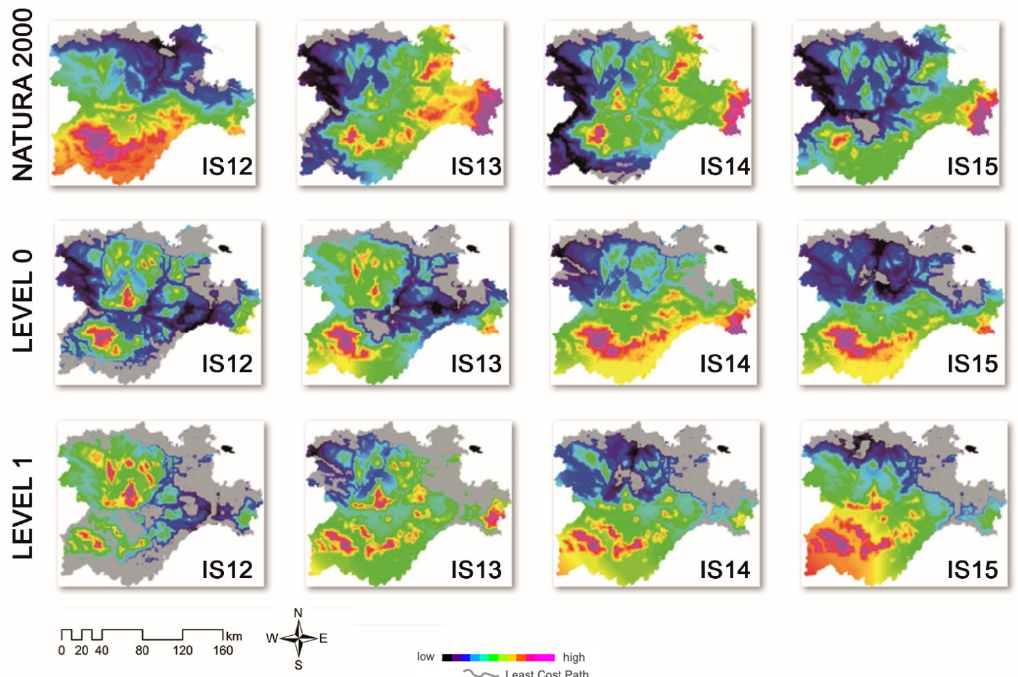
Figure 5. Cost maps between the five largest objects for the different scenarios. Startand target object are displayed in gray color. Color-coded from minimum (black) to maximum (pink) shows the travel time, where ISxy represents the restoration scenario for connection of x object with y object.